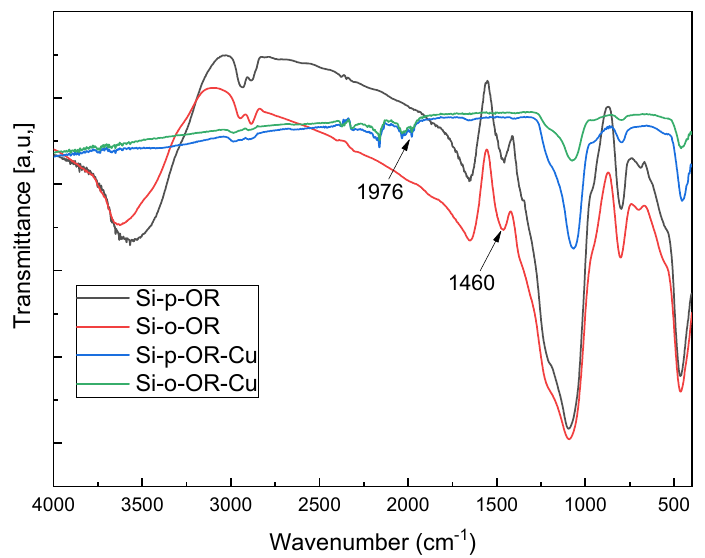
Figure 12. FTIR spectra before and after coordination with Cu(II) for Si-o-OR and Si-p-OR.